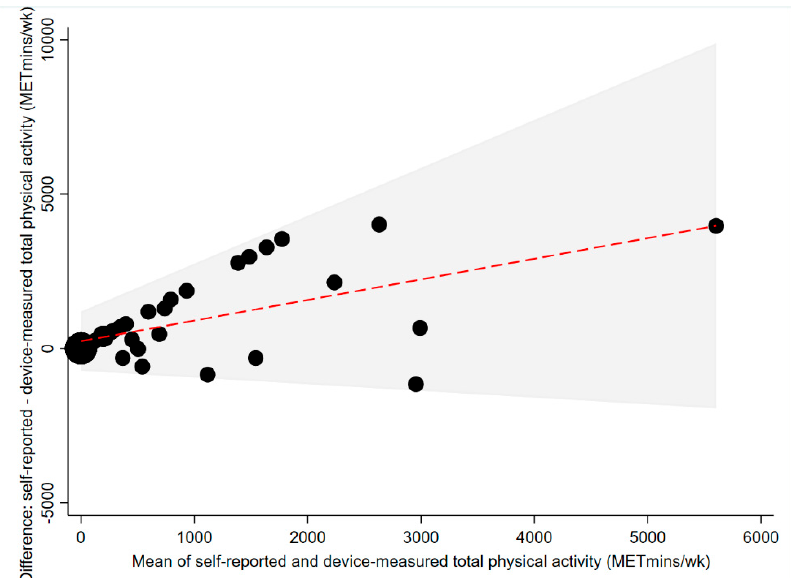
Figure 3. Agreement between self-reported and device-measured total 7-day physical activity (METmins) ( n = 40). The red line represents the mean difference, the grey shaded area represents the limits of agreement and the size of the black dots differs depending on the number of participants that correspond to that value. METmins (Metabolic Equivalent minutes).